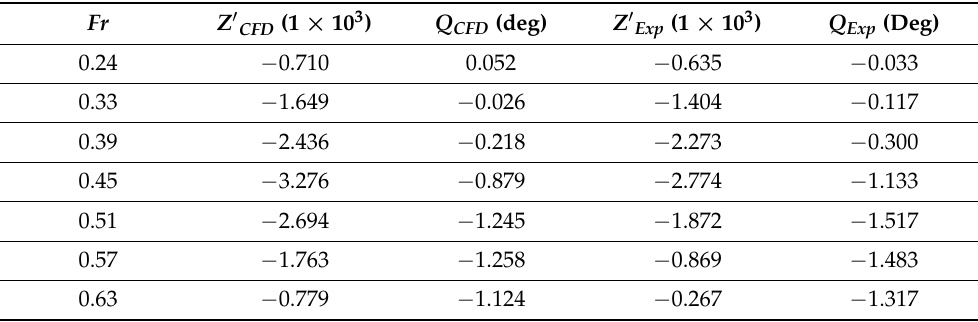
Table 6. Full scale sinkage and trim comparison for LC1.